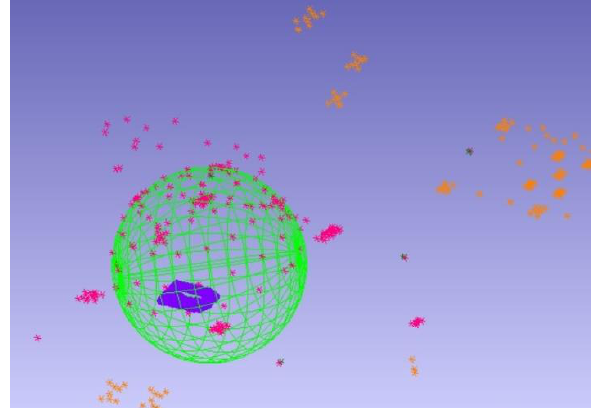
Figure 5. Wide target field constellation [orange], targets and lamps on the dome [red], dense target test plate probe points [purple] and best fit sphere to the lamp locations